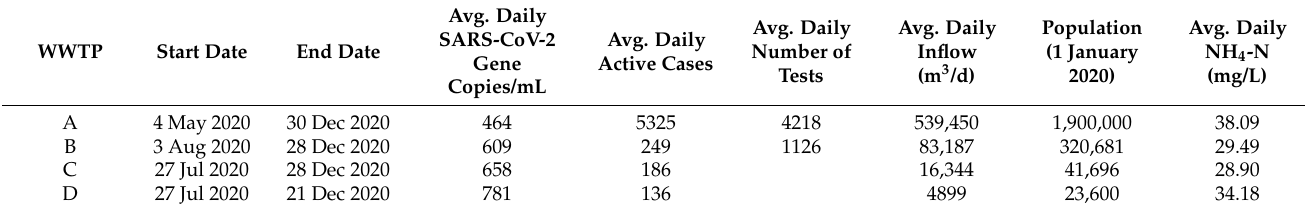
Table 1. Summary of wastewater treatment plant